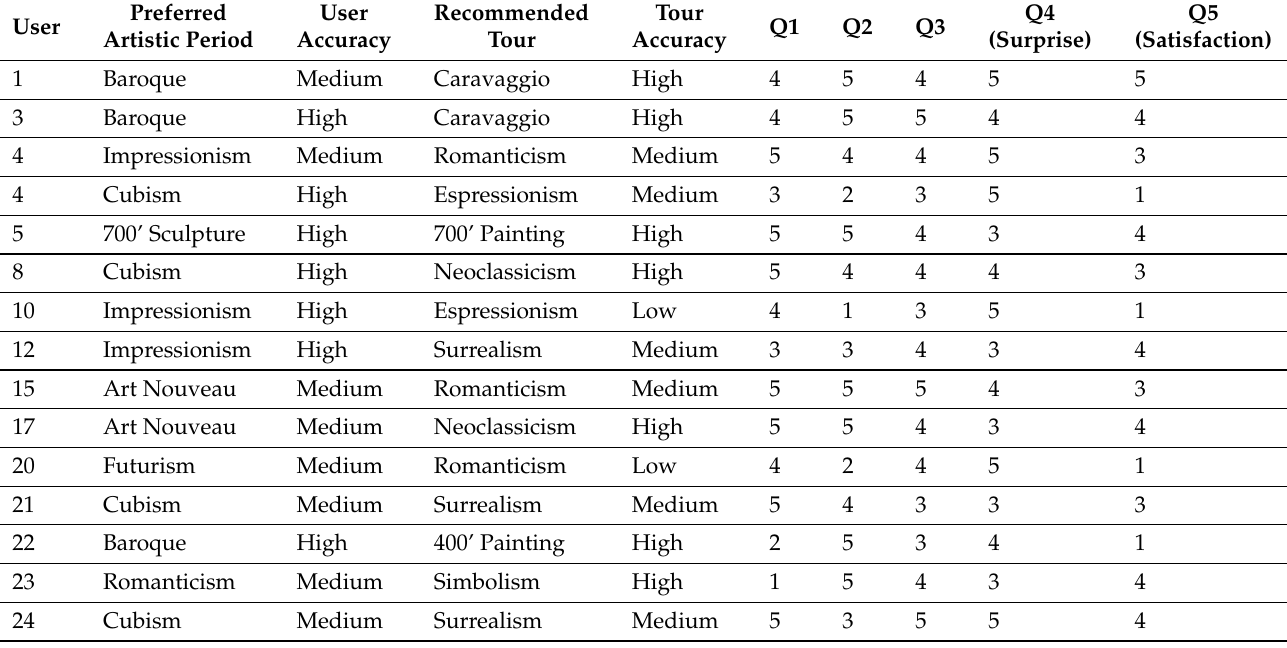
Table 2. The table summarizes the answers provided by the users to the survey questions after the robot provided critical help to the user. The robot recommended a tour different to the preferred user’s artistic